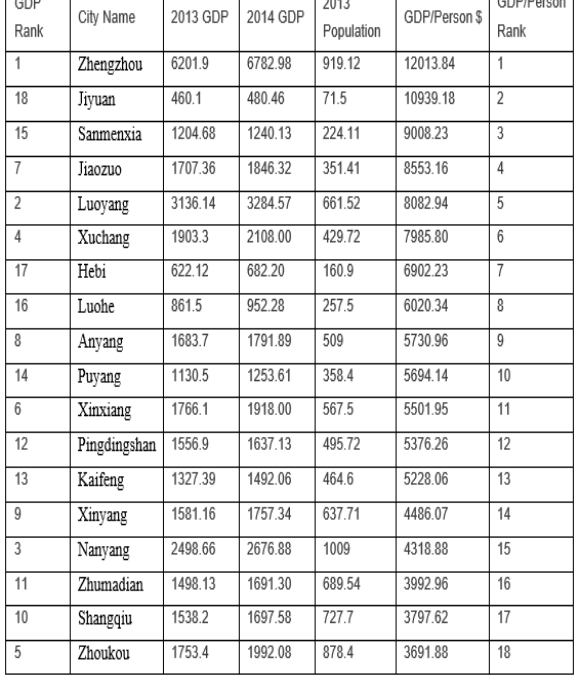
Table 1. Economic Index for Henan Province in 2013